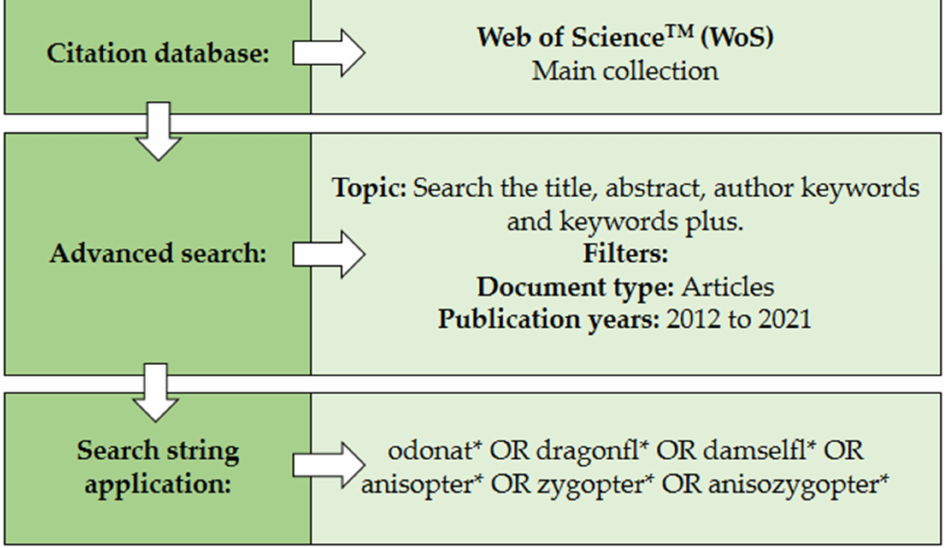
Figure 1. Methodology overview, with search terms and search strings (boolean operator) used to obtain global research on Odonata, available from the Web of Science database